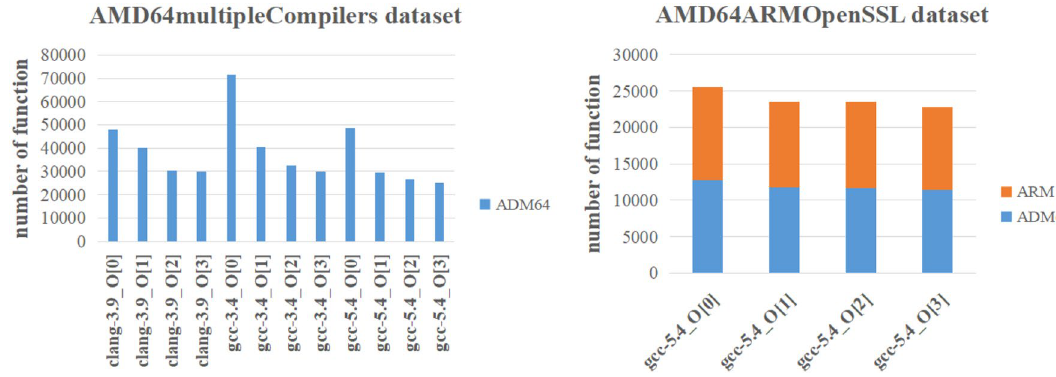
Figure 4. Datasets analysis.